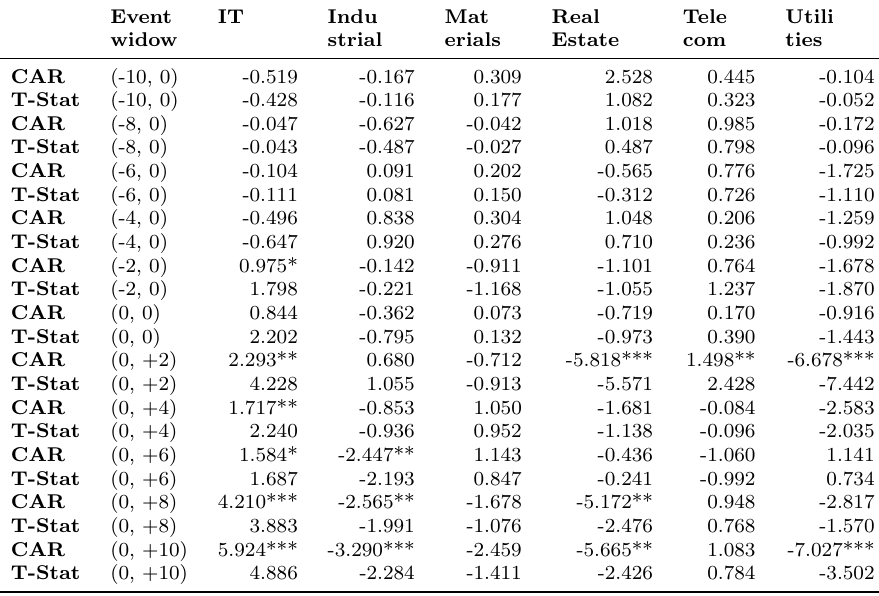
Table 4: Event 2: 26-02-2020 First Local Transmission